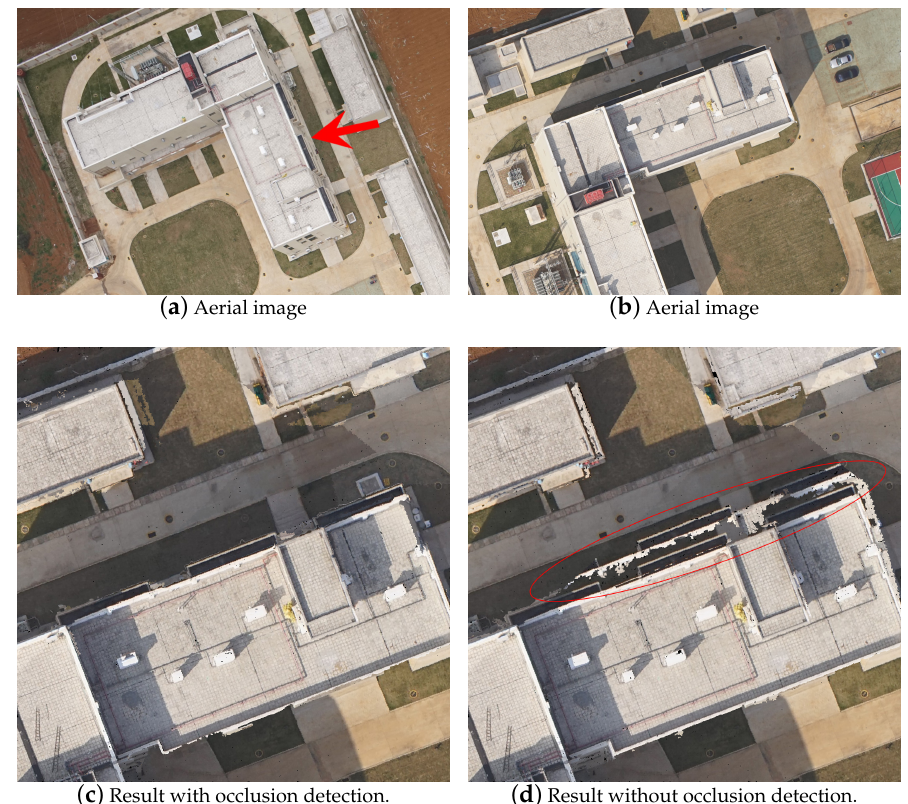
Figure 13. An example of the occlusion. A part of the lawn (pointed by an arrow) in ( a ) is occluded by the nearby building, as shown in ( b ). ( c , d ) are digital orthophoto results generated with and without occlusion detection. We use the red ellipse to mark the incorrect texture, as shown in ( d